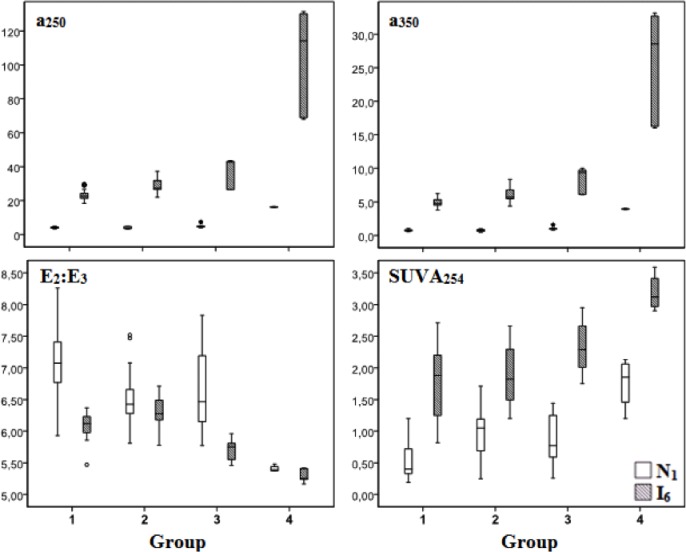
Boxplots of the UV-visible spectroscopic parameters a250 (m-1), a350 (m-1), E2:E3 ratio and SUVA250 (L mg-1 C-1 m-1) within the different groups of samples at the marine (station N1) and brackish water (station I6) zones of the estuary Ria de Aveiro.